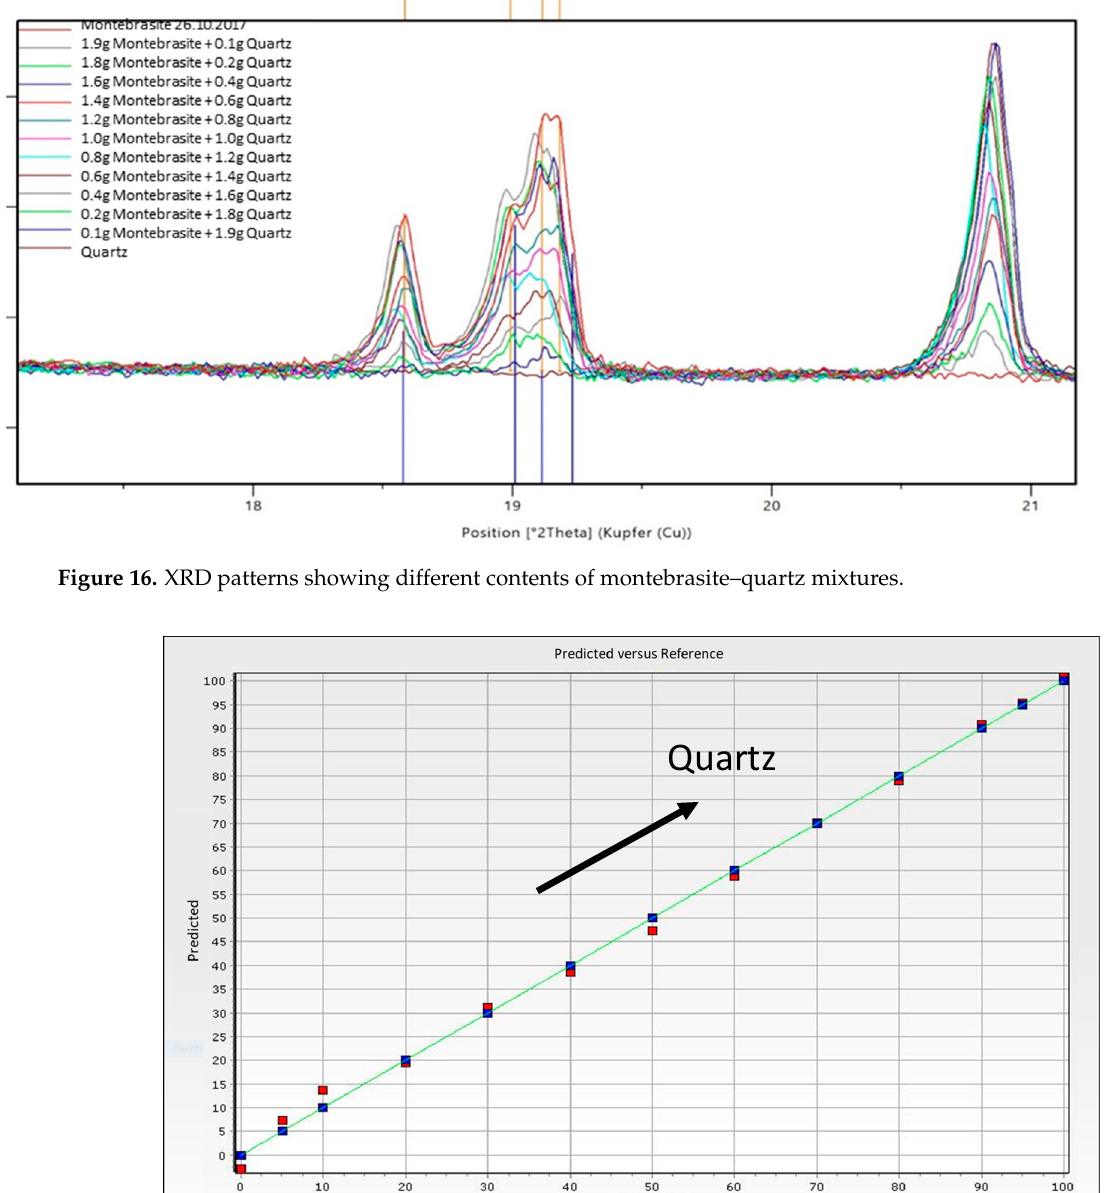
Figure 17. Calibration curve for montebrasite–quartz mixtures. The clustering of XRD scans revealed four clusters of (a) SiO 2 -rich, (b) Montebrasite- rich, (c) intermediate Montebrasite, and (d) intermediate SiO 2 -contents (Figure 18).